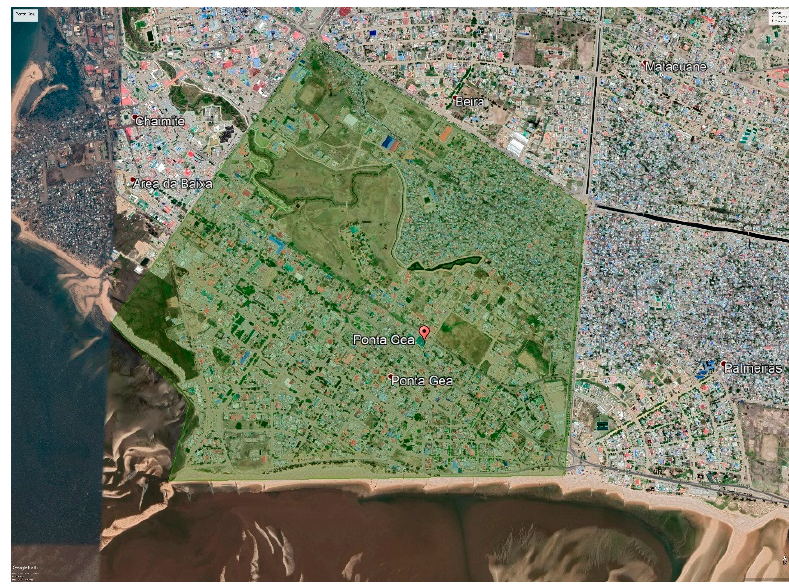
Figure 1. Location of the Ponte Gêa neighborhood